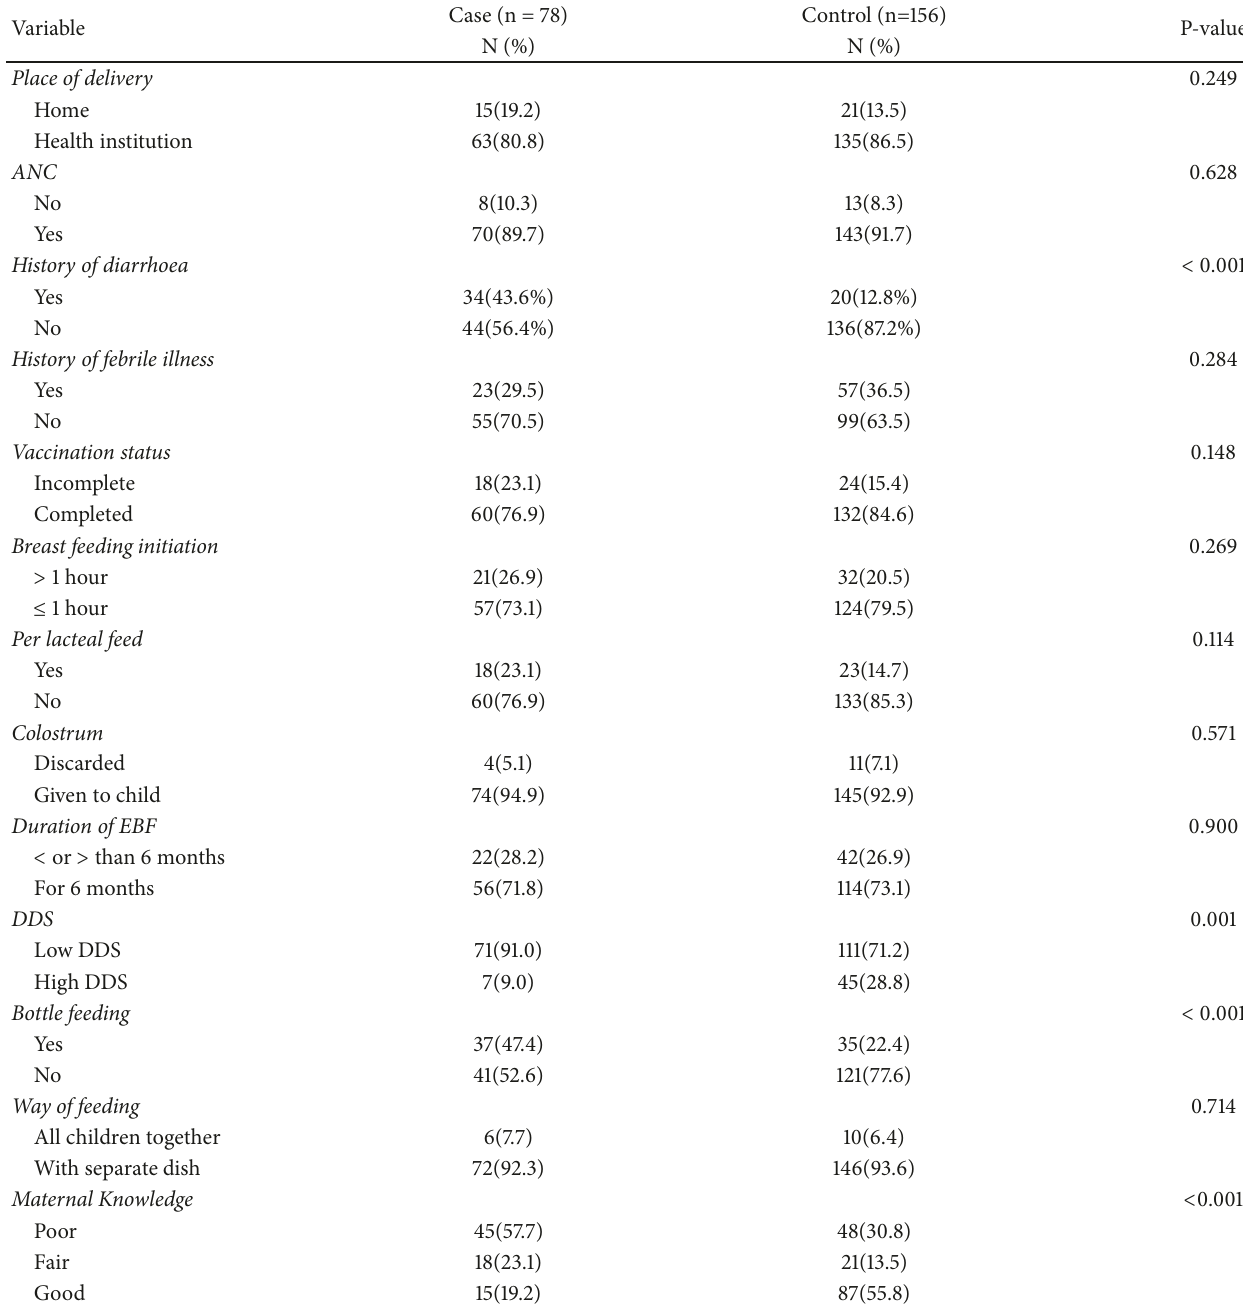
Table 2: Maternal and child health care related factors of study participant of Nekemte town, West Ethiopia, 2017